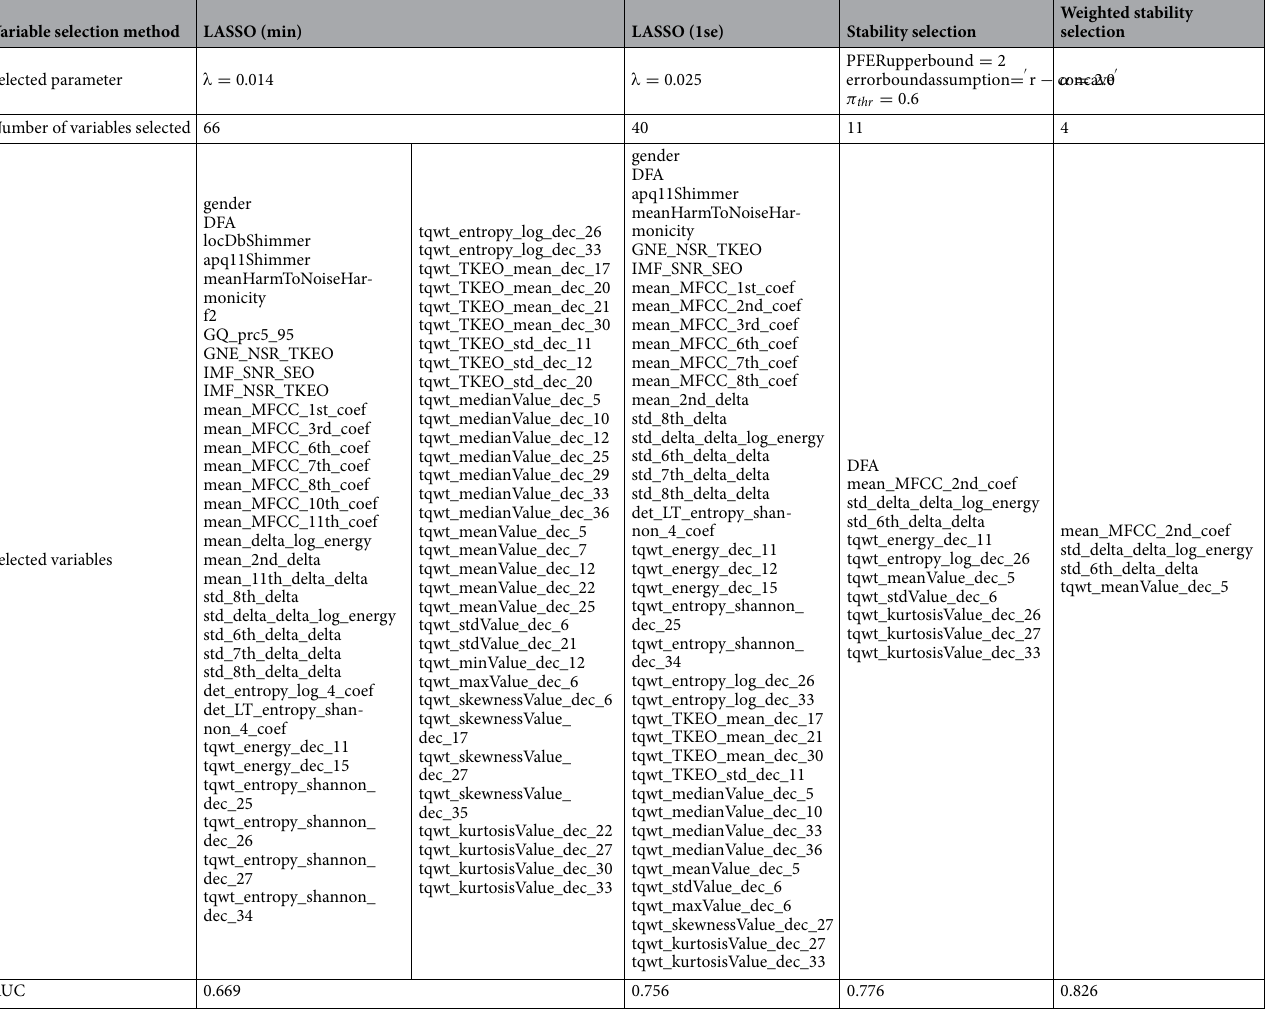
Table 2. Results of variable selection for four different methods using a speech signal data on Parkinson’s